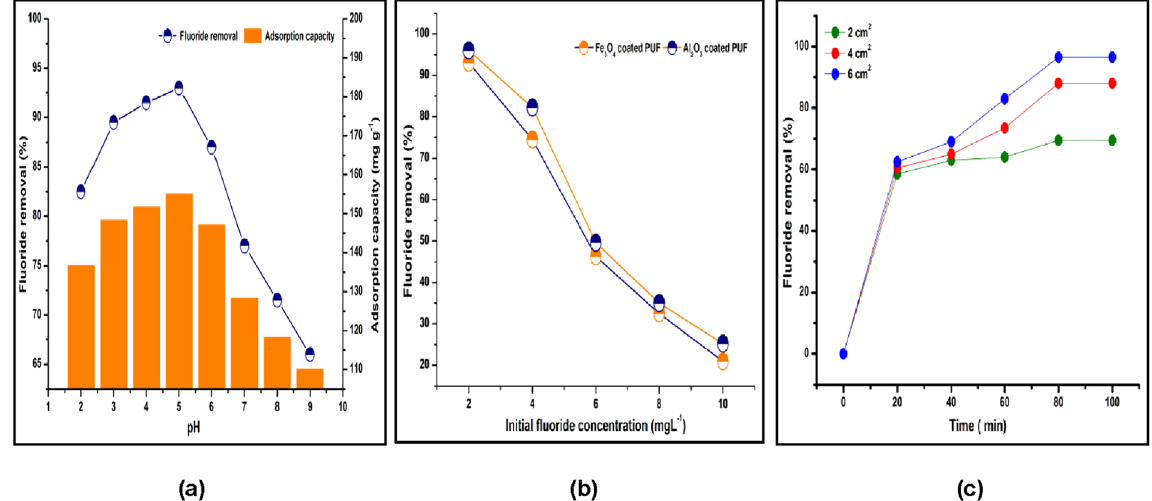
Figure 4. ( a ) Effect of pH (Time: 80 min, Foam size: 6 × 6 cm 2 and Fe 3 O 4 NPs-PUF), ( b ) Effect of Initial F concentration (Time: 80 min, Foam size: 6 × 6 cm 2 , pH: 5 for Fe 3 O 4 NPs-PUF and 6 for Al 2 O 3 NPs-PUF), ( c ) Effect of PUF size (pH: 6 for Al 2 O 3 NPs-PUF, F concentration: 2 mg L − 1 ).